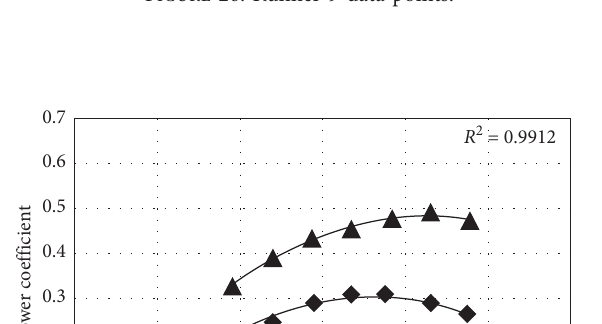
Figure 29: Runner 12 data points.